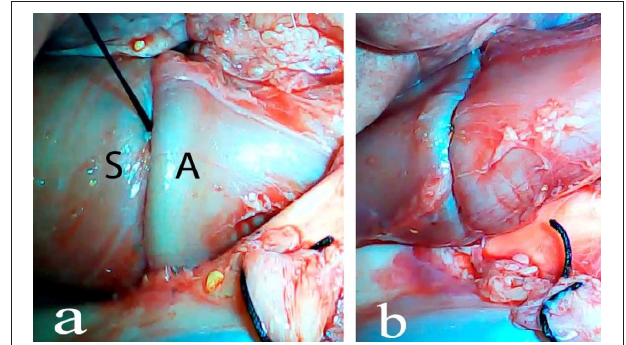
FIGURE 4 | Closure of the stapler and stapler deployment. S, stapler; A, anvil (a) , esophago-esophageal anastomosis after stapler deployment and transgastric stapler extraction (b) .